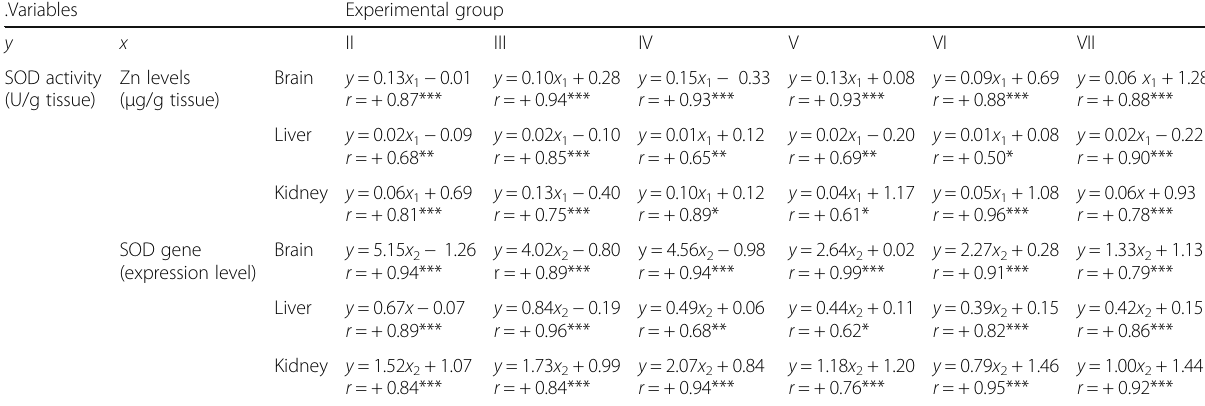
Table 5 Fitting equations and correlation coefficients ( r ) of SOD activity ( y ) with the levels of Zn ( x 1 ) as well as the expression levels of SOD gene ( x 2 ) in the brain, liver, and kidneys of rats administered 0.5g and 1.0g of NiO-NPs (II and III), 0.5g and 1.0g of Co 3 O 4 -NPs (IV and V), as well as mixtures of NiO-NPs + Co 3 O 4 -NPs (0.25g + 0.25g, VI) and (0.5g + 0.5g, VII) per kilogram body weight, respectively